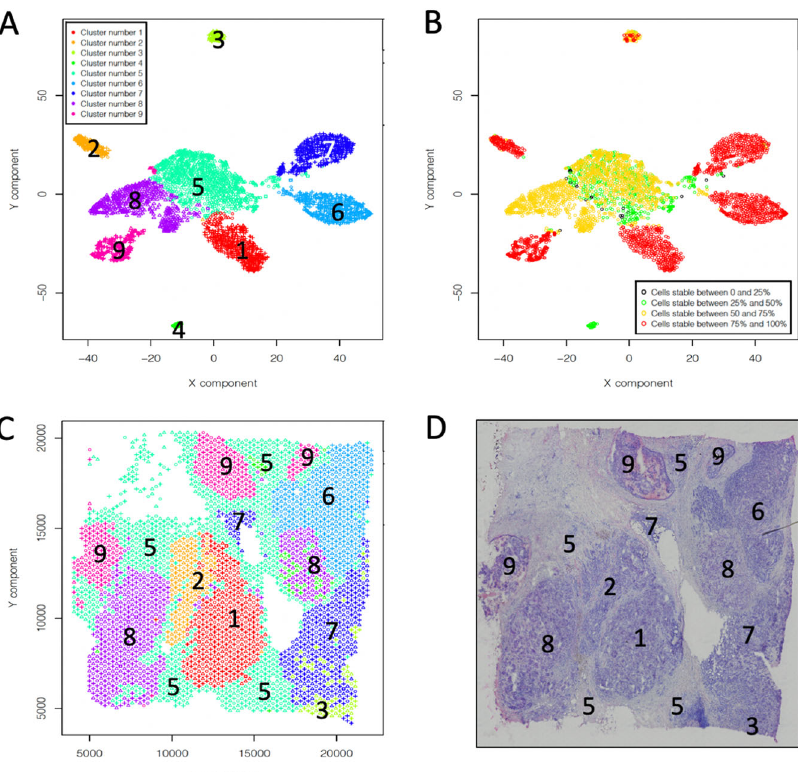
Fig. 6 Analysis of human breast cancer (Block A Section 1), from 10XGenomics Visium Spatial Gene Expression 1.0.0. demonstration samples. a SIMLR partitioning in 9 clusters. b Cell stability score plot for SIMLR clusters in A. c SIMLR clusters location in the tissue section. d Hematoxylin and eosin